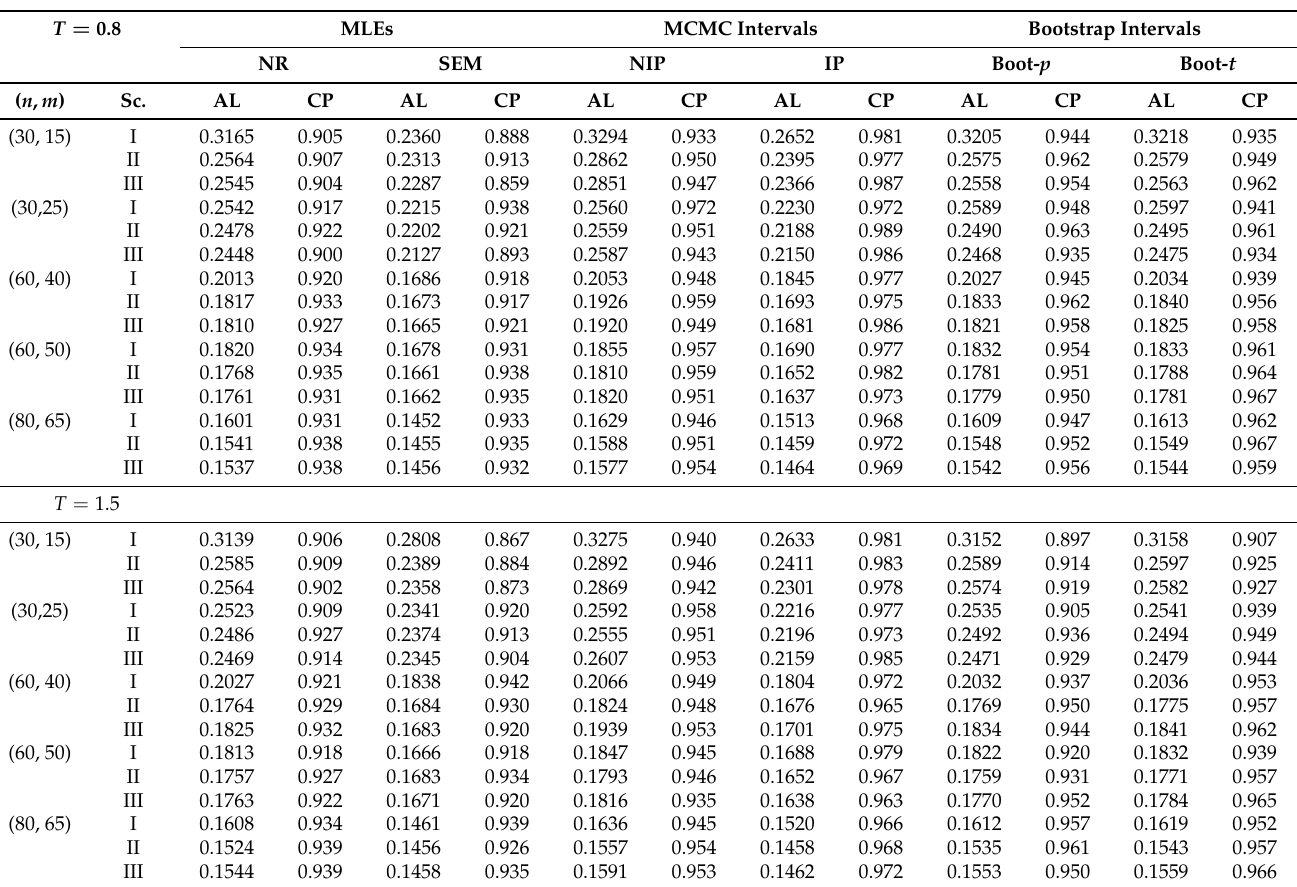
Table 15. 95% CI’s, average length (AL) and coverage percentage (CP) of approximate, Bayes and bootstrap confidence intervals of S (t = 0.9) under informative prior (IP) and noninformative (NIP) prior, for different schemes with different values of n and m when ( θ 1 , θ 2 , λ ) = (0.05, 0.06,